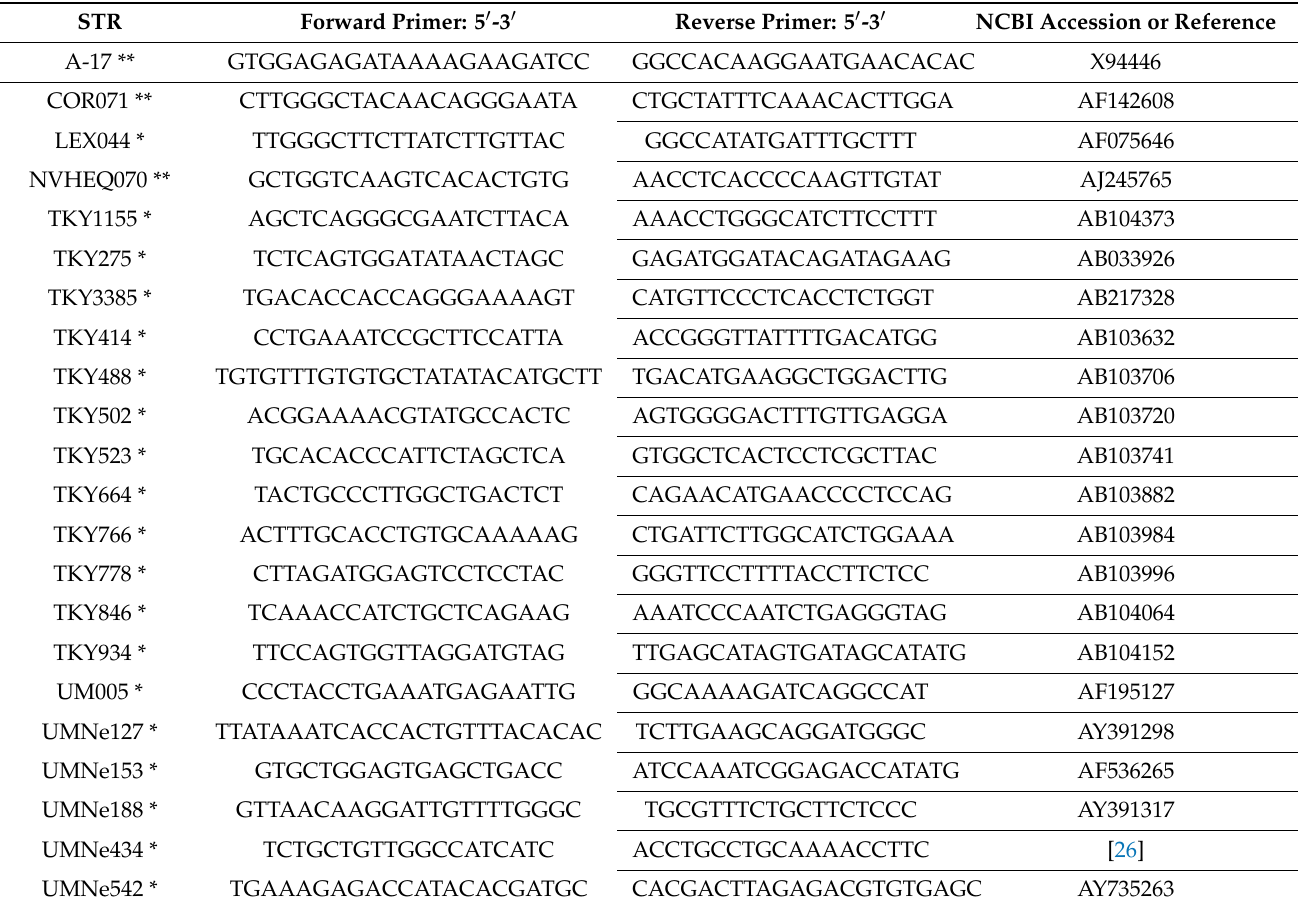
Table 2. Information about ECA26 STR markers used for